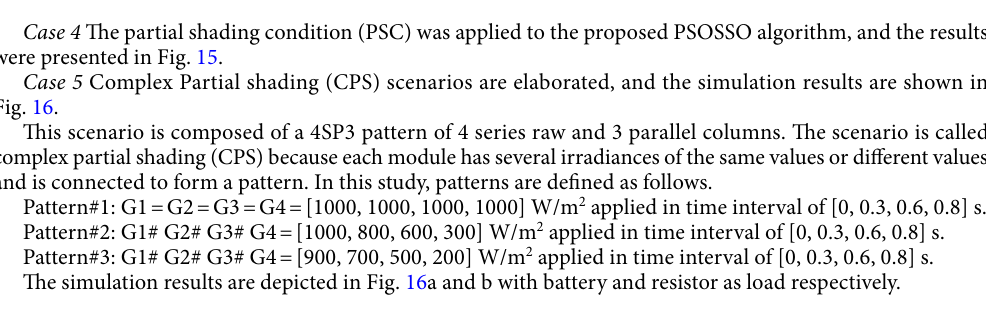
Figure 12. Tracking mechanism of PSOSSO under partial shading condition with linear load (resistor)